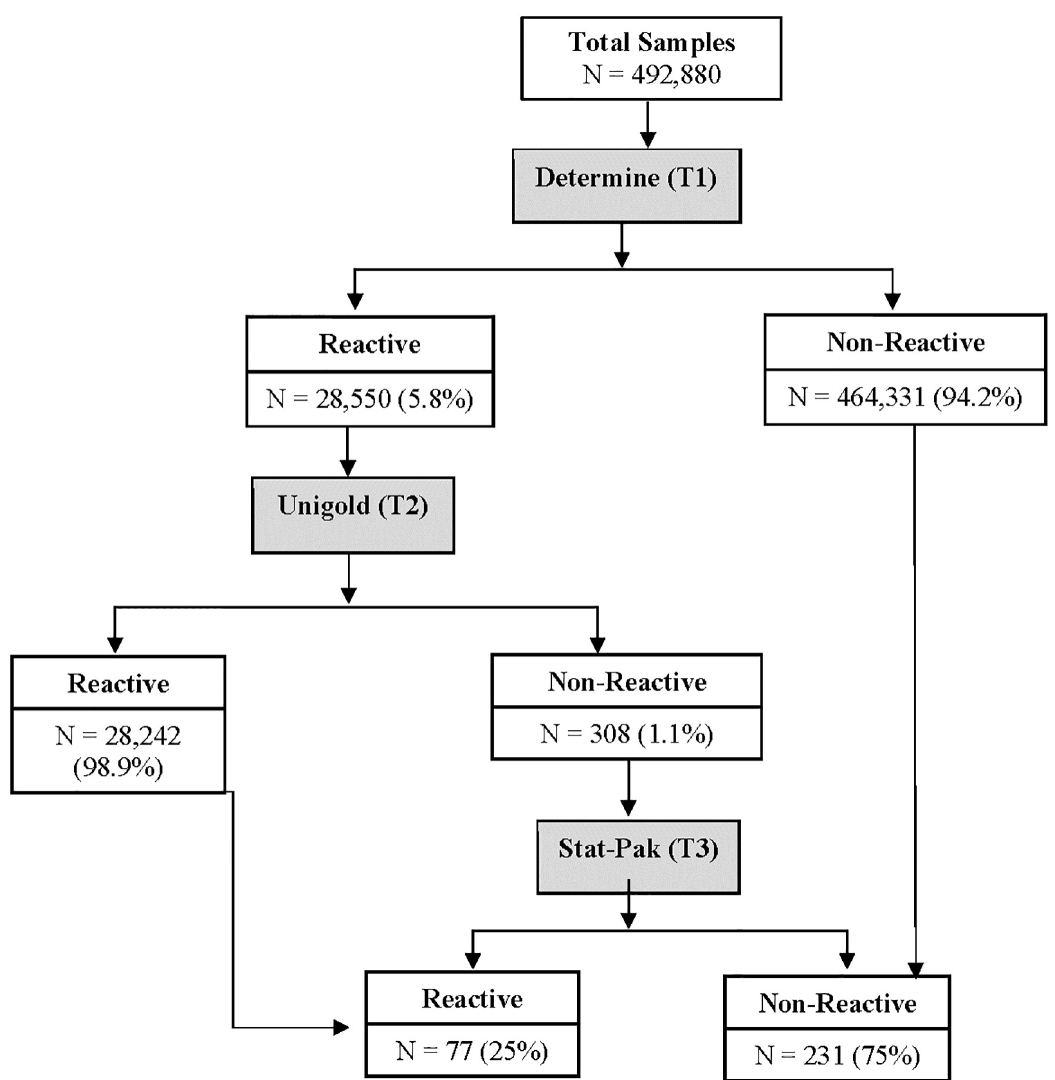
Fig 2. Flowchart of the national serial HIV rapid testing algorithm performed at the testing sites for retrospective evaluation. N = number, T = test.